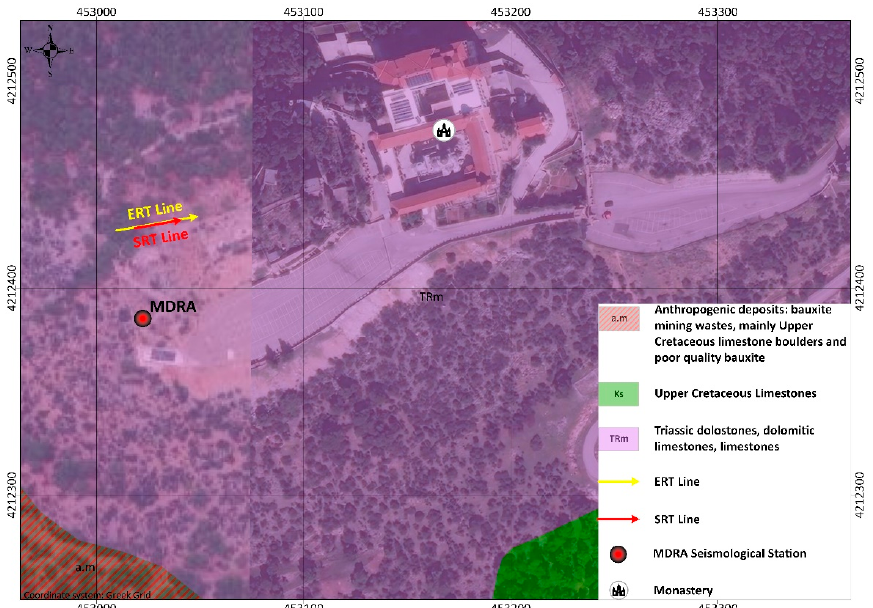
Figure 3. Location of the seismological station MDRA and the geophysical measurements along with the geology of the area.